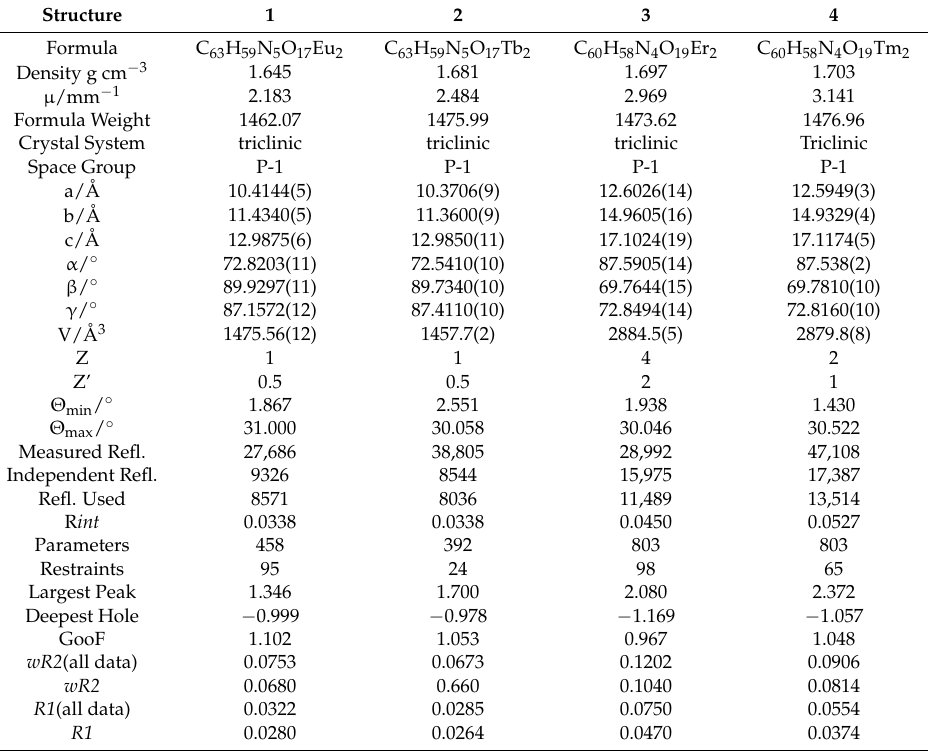
Table 1. Crystal structure and refinement data for 1 – 4